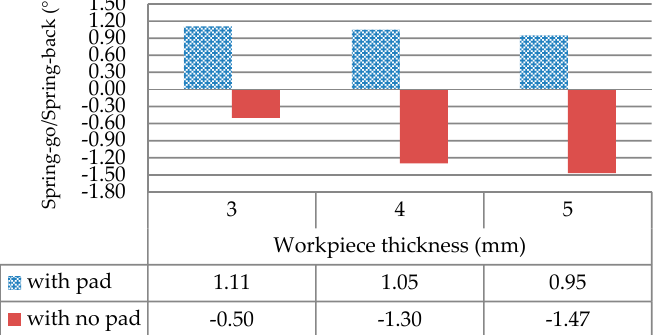
Figure 7. Comparison of the predicted spring-back/spring-go between the cases of U-bending with and without pressure pads, with respect to workpiece thicknesses (θ: 90°, R p : 5 mm, W : 30 mm, WP L : 120 mm, R ud : 5 mm).